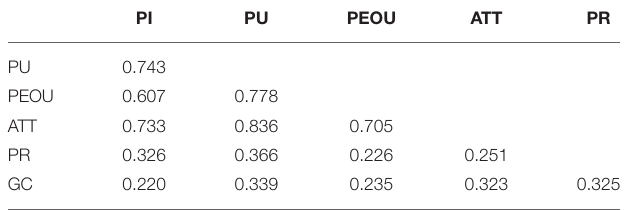
TABLE 4 | HTMT results.